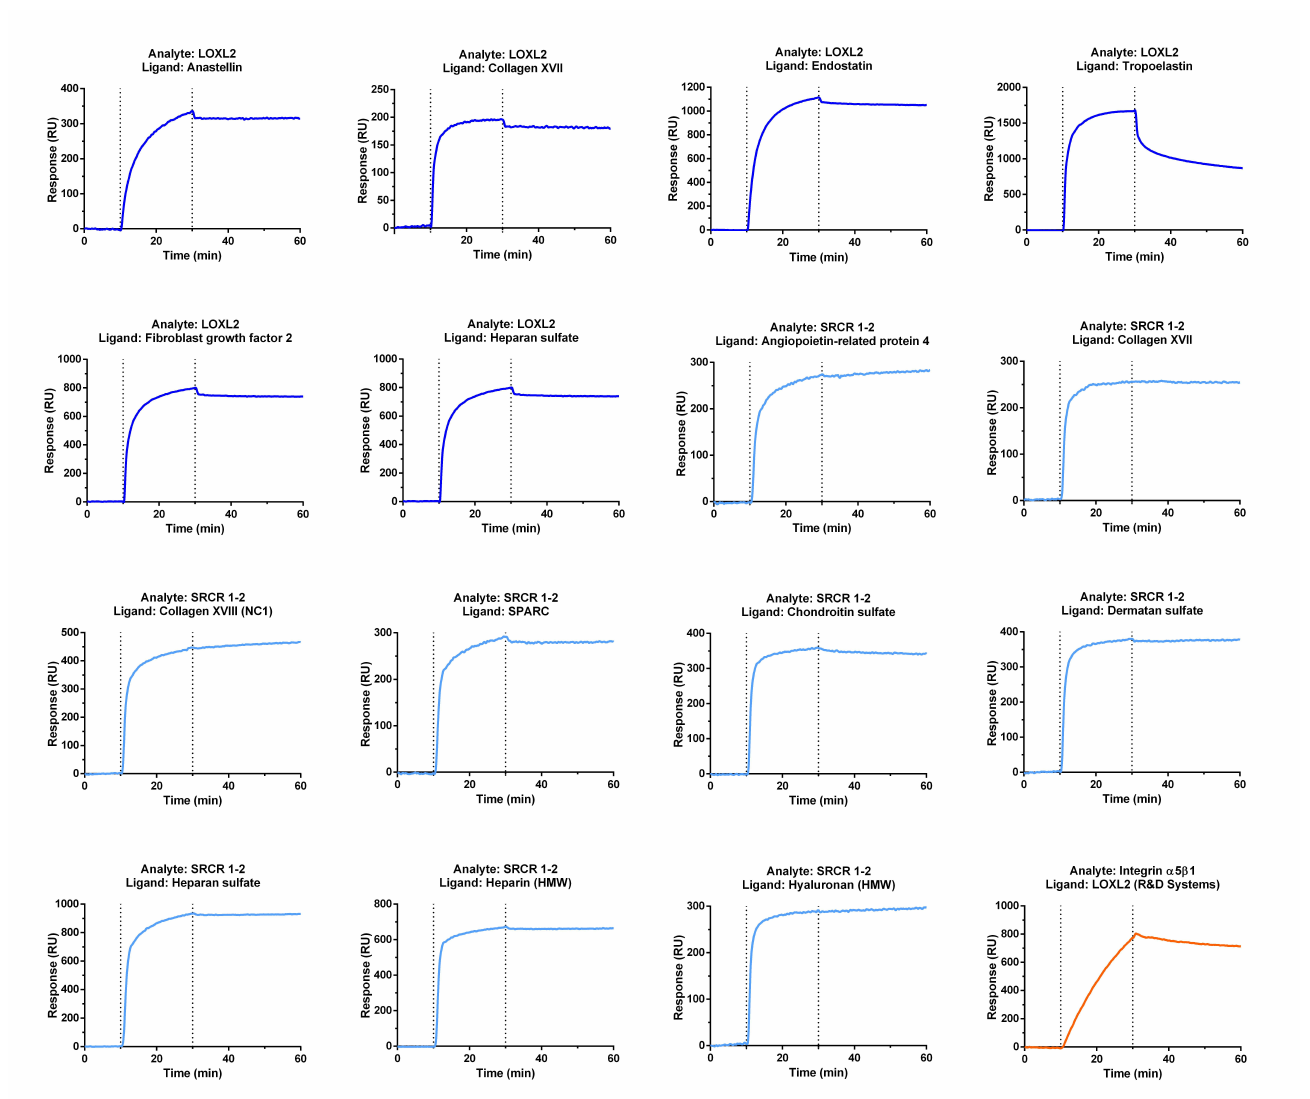
Figure 1. Partners of LOXL2 identified by surface plasmon resonance imaging binding assays. LOXL2 and its N-terminal SRCR domain SRCR 1-2 were injected and recirculated over ECM protein and GAG arrays probed by SPR imaging. Non- specific binding to the array surface was subtracted from the raw signals obtained on protein and GAG spots to get specific binding. The resulting sensorgrams were smoothed. The analytes were color-coded (LOXL2: deep blue, SRCR 1-2: light blue, α 5 β 1 integrin: orange). Tropoelastin, previously identified by surface plasmon resonance as a binding partner of LOXL2 [50], was used as a positive control. HMW: high molecular weight, dotted lines: start and end of the recirculation